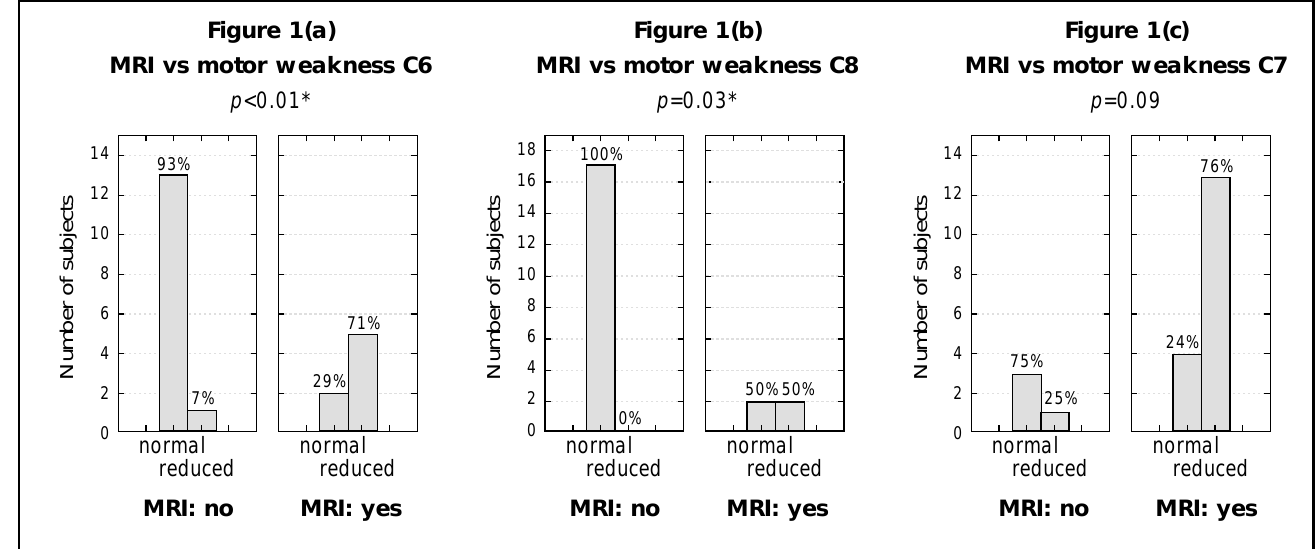
Figure 1: Comparison between MRI findings and clinically demonstrated myotomal motor weakness for